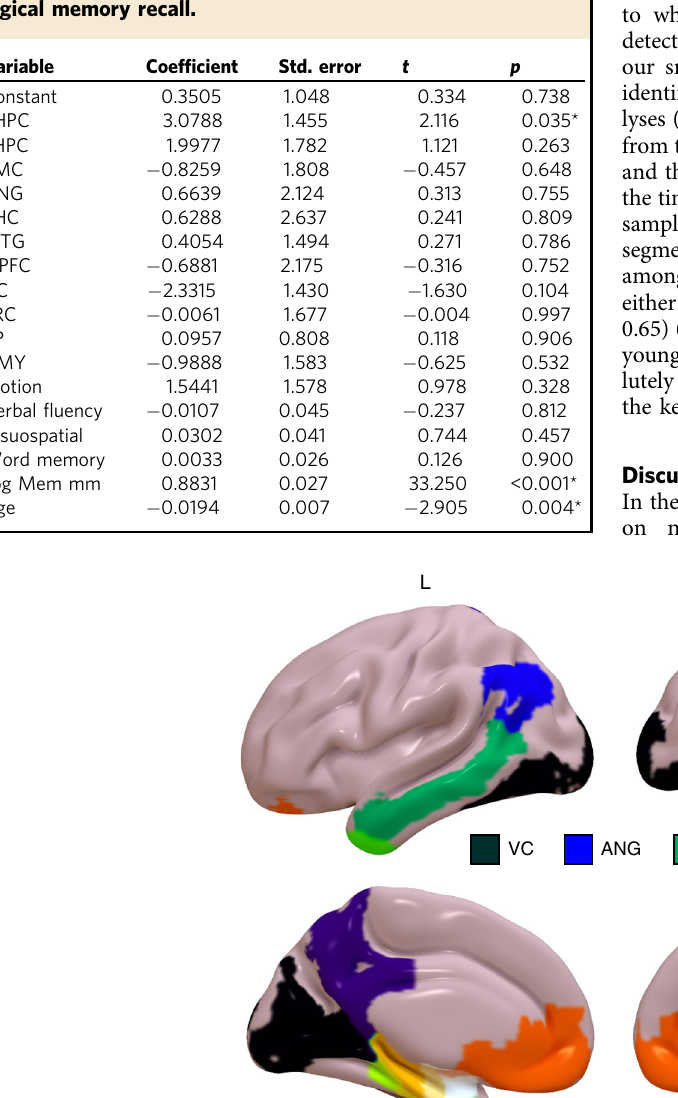
Table 2 Regression analysis results, predicting delayed logical memory